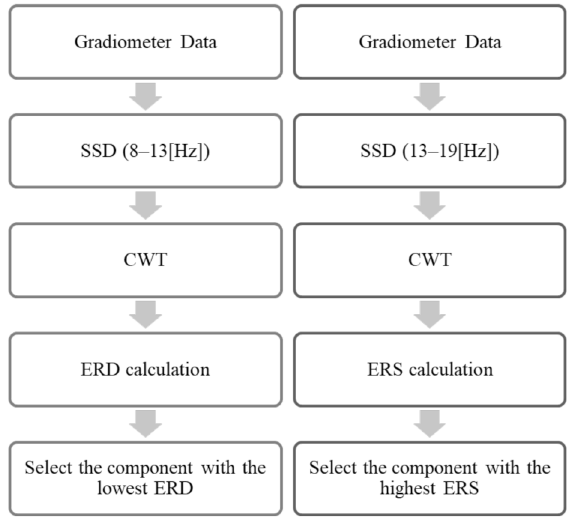
Figure 4. The flow of SSD